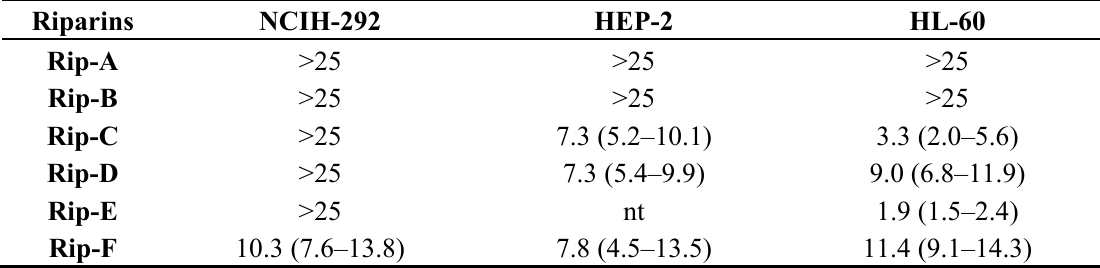
values and confidence intervals in µg/mL for riparins A, B, C, D and F on Table 5. IC 50 tumor cell